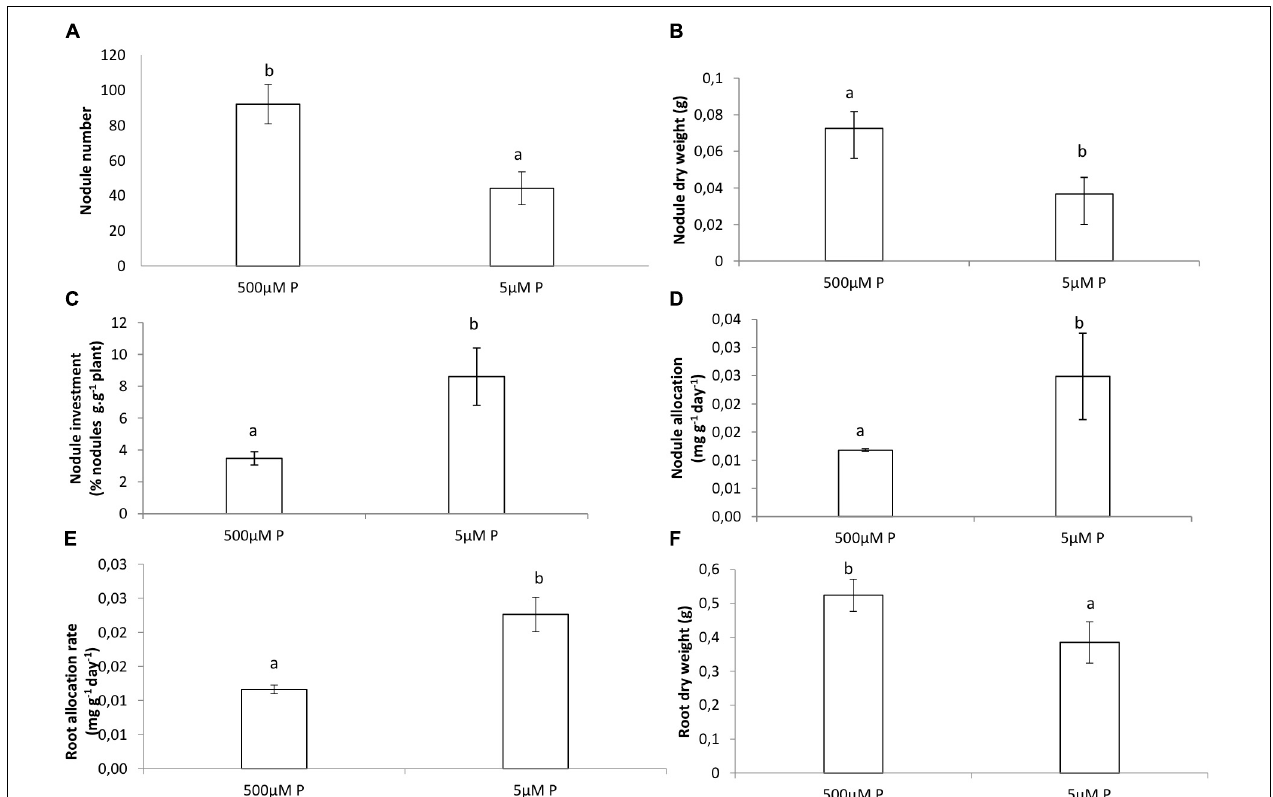
FIGURE 1 | (A) Amount of nodules on roots, (B) dry weight of nodules, (C) nodule % of plant dry weight, (D) nodule allocation rate, (E) root allocation rate, (F) root dry weight of Virgilia divaricata grown under high phosphate (500 µ M P) and low phosphate (5 µ M P) conditions. Values of four replicates are presented as means ± SE. Different letters indicate significant differences between treatments ( P ≤